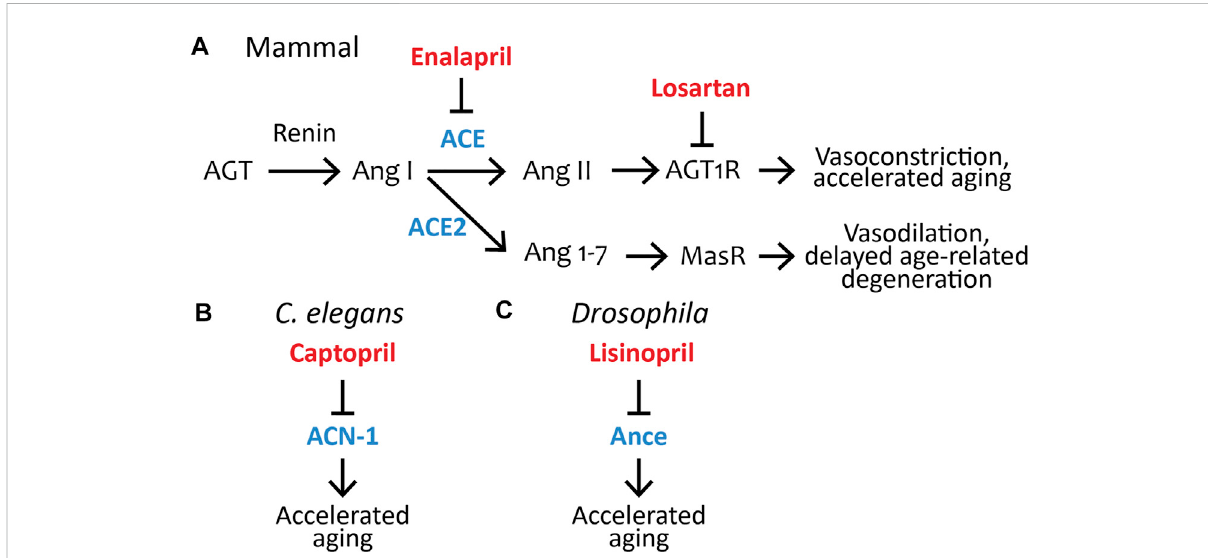
FIGURE 1 Pharmacological inhibition of the renin – angiotensin system in fl uences aging in C. elegans , Drosophila , and mammals. (A) The RAS pathway in mammals; the ACE inhibitor Enalapril and angiotensin II type-1 receptor blocker Losartan are FDA-approved drugs that control aging in non-human mammals(seeTable1).AGT,Angiotensinogen;AngI,AngiotensinI;ACE,Angiotensin-convertingenzyme;AngII,AngiotensinII;AGT1R,Angiotensin II type-1 receptor; ACE2, Angiotensin-converting enzyme 2; Ang 1-7, Angiotensin (1-7); MasR, Mas Receptor. (B) The FDA-approved ACE- inhibitor drug Captopril inhibits acn-1, the only C. elegans ACE homolog, to control aging (Kumar et al., 2016). ACN-1, Angiotensin-converting enzyme-like non-peptidase. (C) The FDA-approved ACE inhibitor drug Lisinopril inhibits Ance, the Drosophila ACE homolog, to control aging (Gabrawy et al., 2019). Ance, ANgiotensin-converting enzyme. Blue, ACE and its homologs ACE2, Ance, and ACN-1; red, ACE inhibitors (Captopril, Enalapril, Lisinopril) or ARBs (Losartan), which have been shown to in fl uence